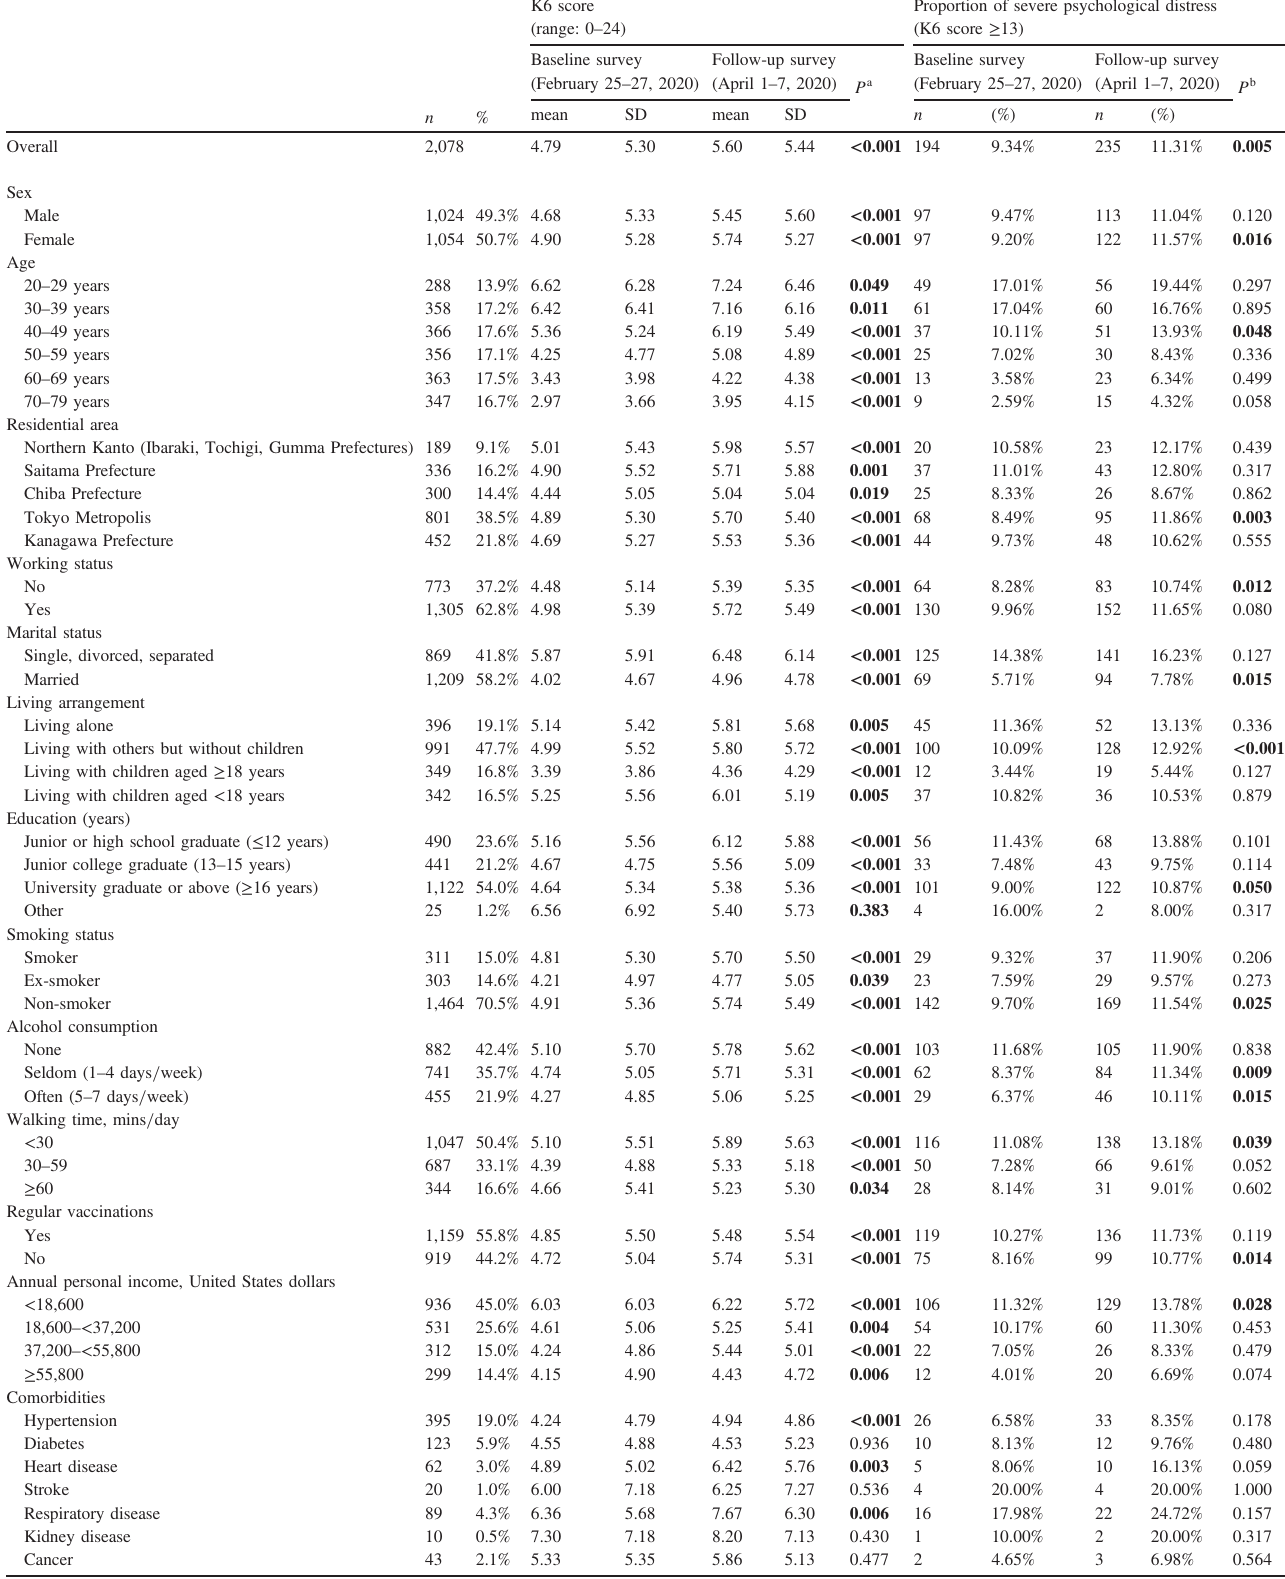
Table 1. Di ff erences in psychological distress by individual factor